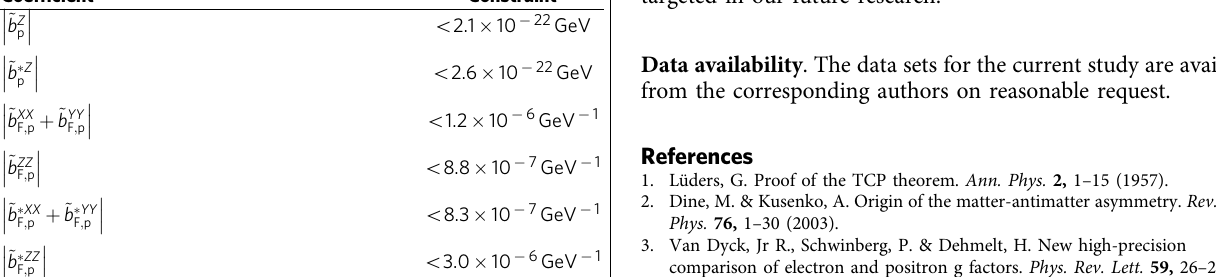
Table 1 | List of all SME-coefficients constrained by this measurement.